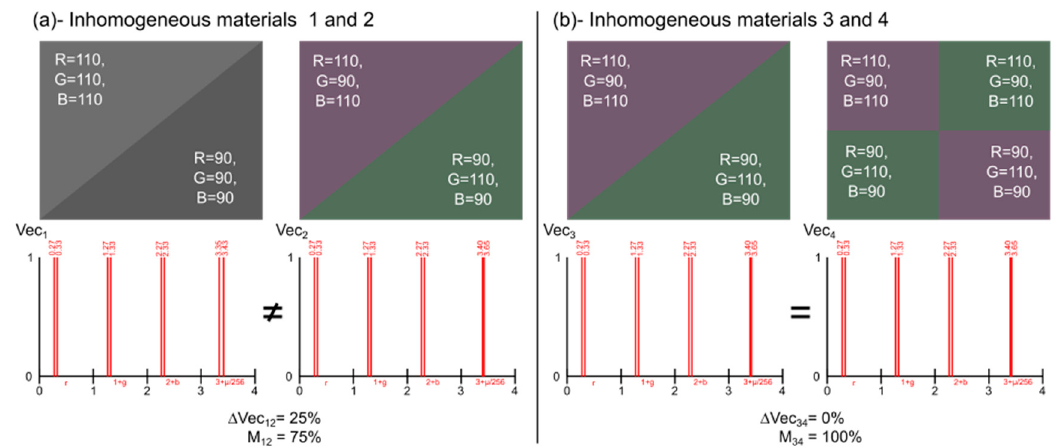
Figure A13. Schematics illustrating inhomogeneous materials and their associated CaliPhoto vectors, defined by Equation (3). The CaliPhoto vector as defined by Equation (3) differentiates any inhomogeneous materials of different colour ( a ). It cannot, however, distinguish materials of similar colours but different textures, as shown in ( b ). Nevertheless, this is not the objective of the method. The CaliPhoto RGB values stored in the database of coloured papers can be replaced by the newly defined CaliPhoto vectors, and material identification can be performed using Equation (A11).